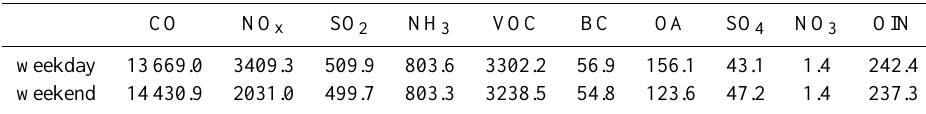
Table 2. Total daily emissions (metric tons) of trace gases and fine particulates (PM 2 . 5 ) over the modeling domain for weekday and week- end periods derived from the 2008 CARB emission inventory (over California) and the 2005 National Emissions Inventory (elsewhere) as described in the text. VOC are the sum of all non-methane volatile organic compounds and other inorganic (OIN) are other inorganic aerosol of unspecified composition.